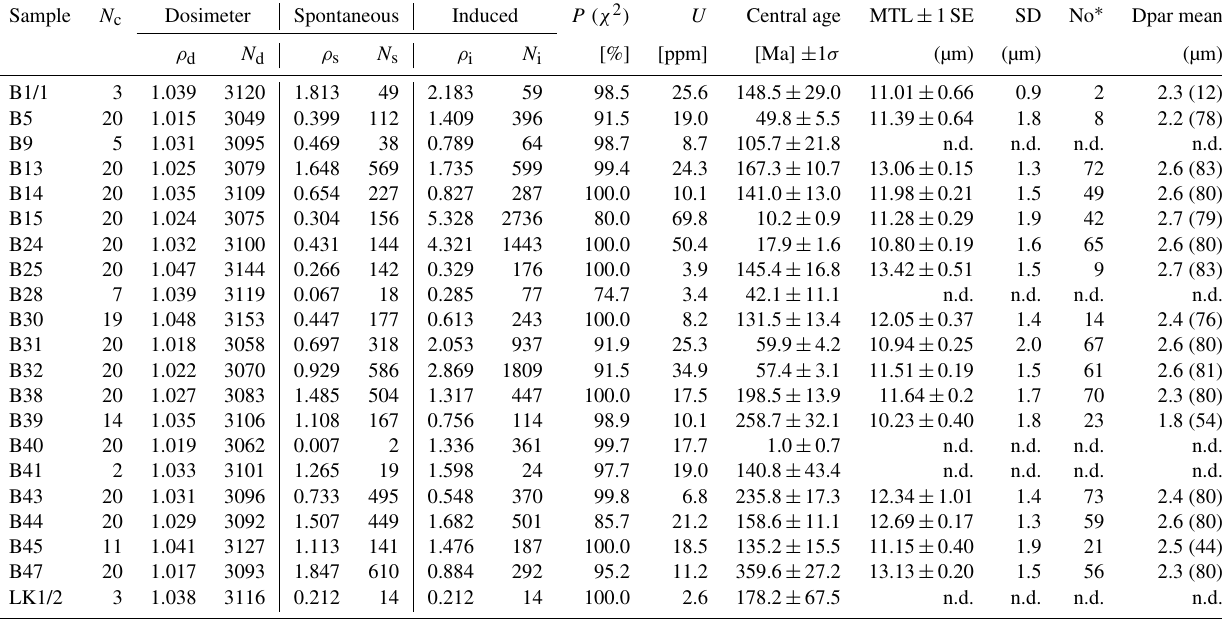
Table 3. Apatite fission track